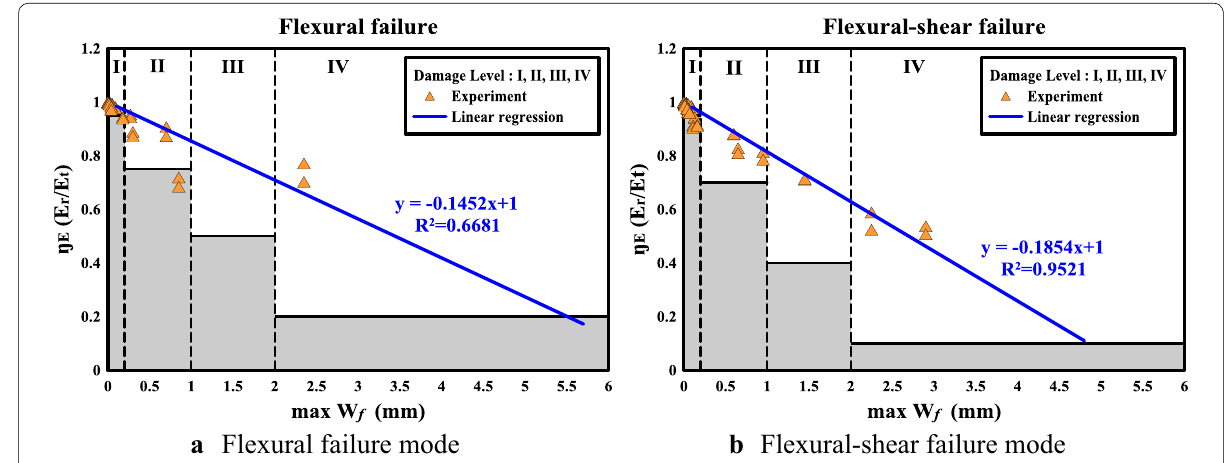
Fig. 14 Experimental reduction factors of energy dissipation capacity for the specimens with the flexural and flexural–shear failure modes.